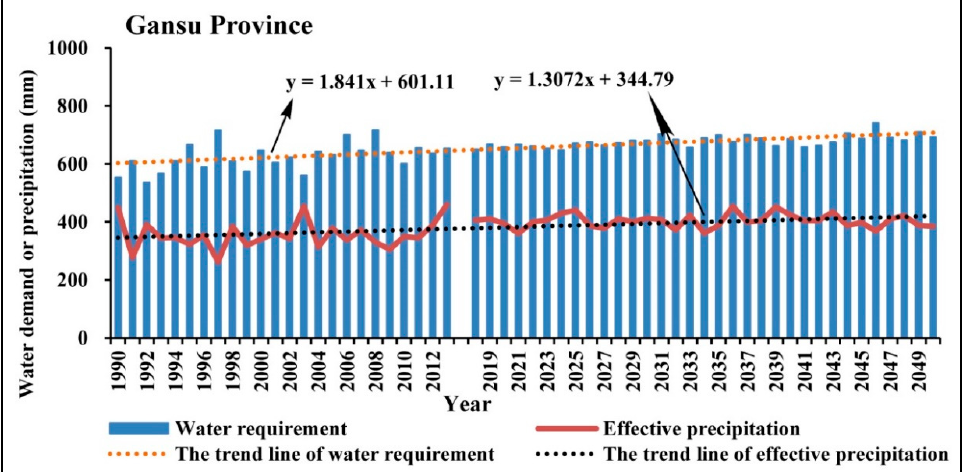
Figure 12. The changing trend of the water demand of apple trees and the effective precipitation in Gansu Province in the periods of 1990–2013 and 2019–2050.